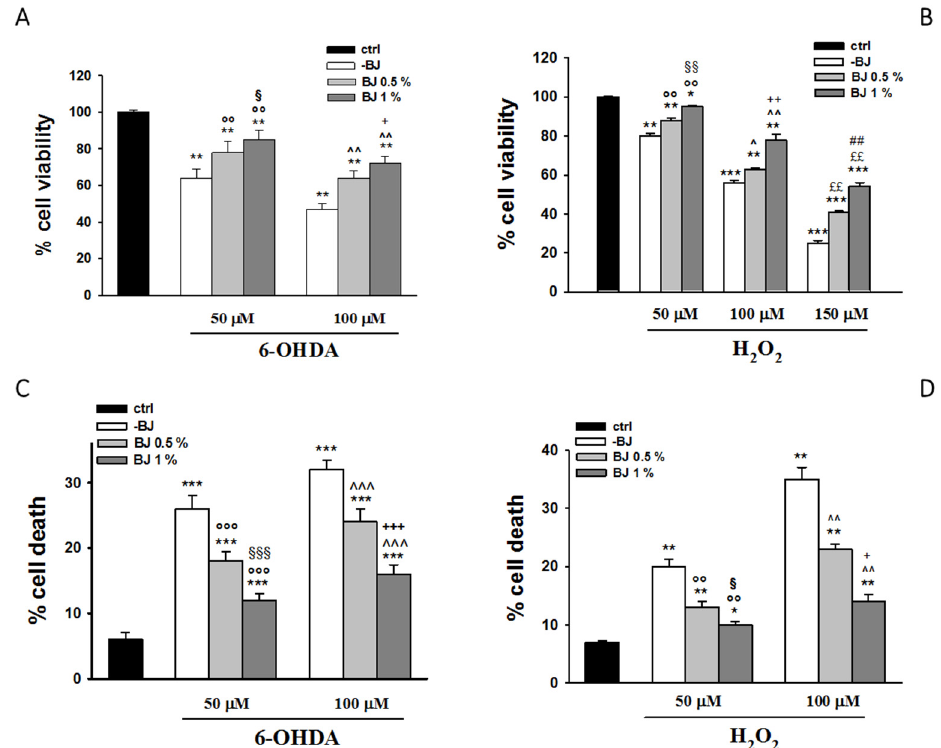
Figure 2. Effect of BJ on cytotoxicity induced by stressors. Cell viability was detected with the 1-(4,5-Dimethylthiazol-2-yl)-3,5-diphenylformazan (MTT) assay ( A and B ). The change of viability was determined as percentage of viable cells in treated cultures compared to those in untreated ones. Cell death was evaluated by the trypan blue (TB) assay and expressed as percentage of non-viable (blue stained) vs. total cells counted ( C and D ). Results are showed as means ± S.E.M. from three independent experiments performed eight-fold (MTT) or in triplicate (TB). * P < 0.05, ** P < 0.01 and